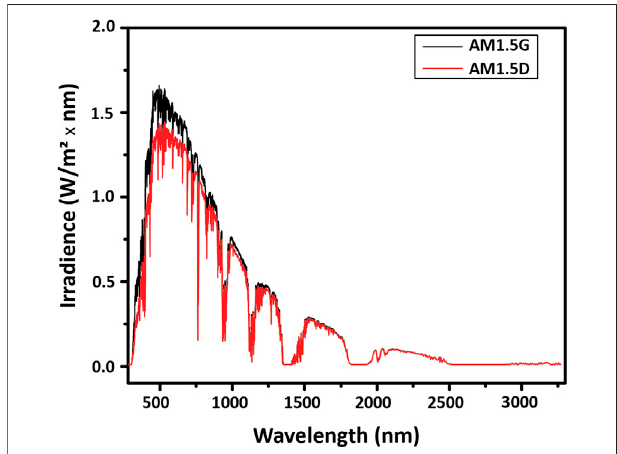
FIGURE 7 | Terrestrial spectral irradiance. Available at https://www.nrel.